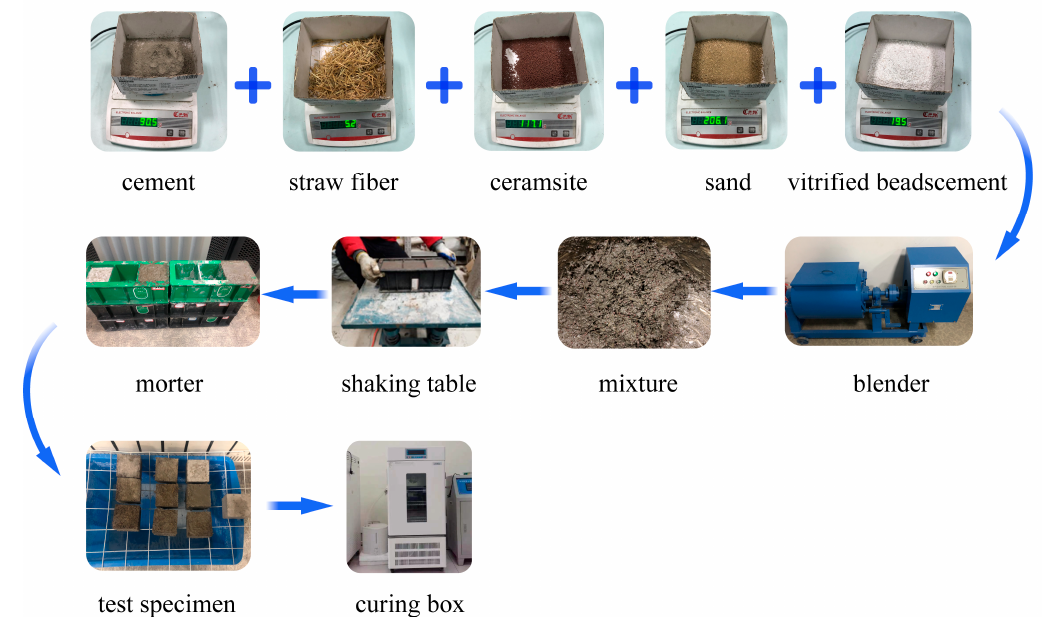
Figure 2. Flow chart of concrete sample